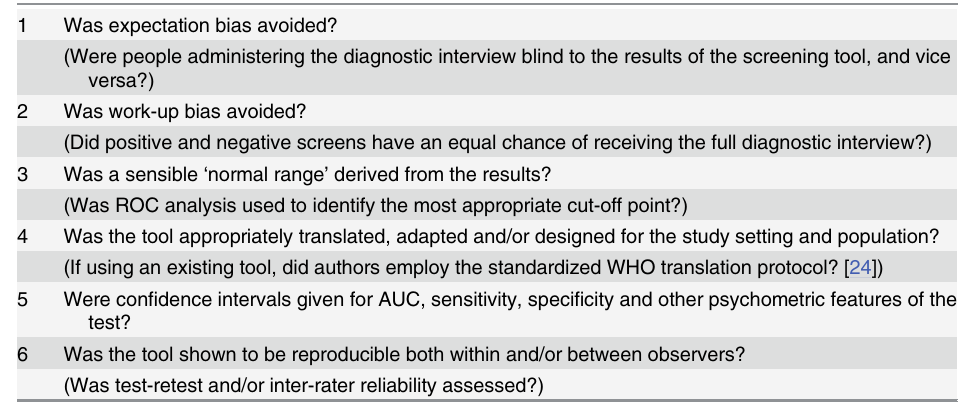
Table 1. Quality